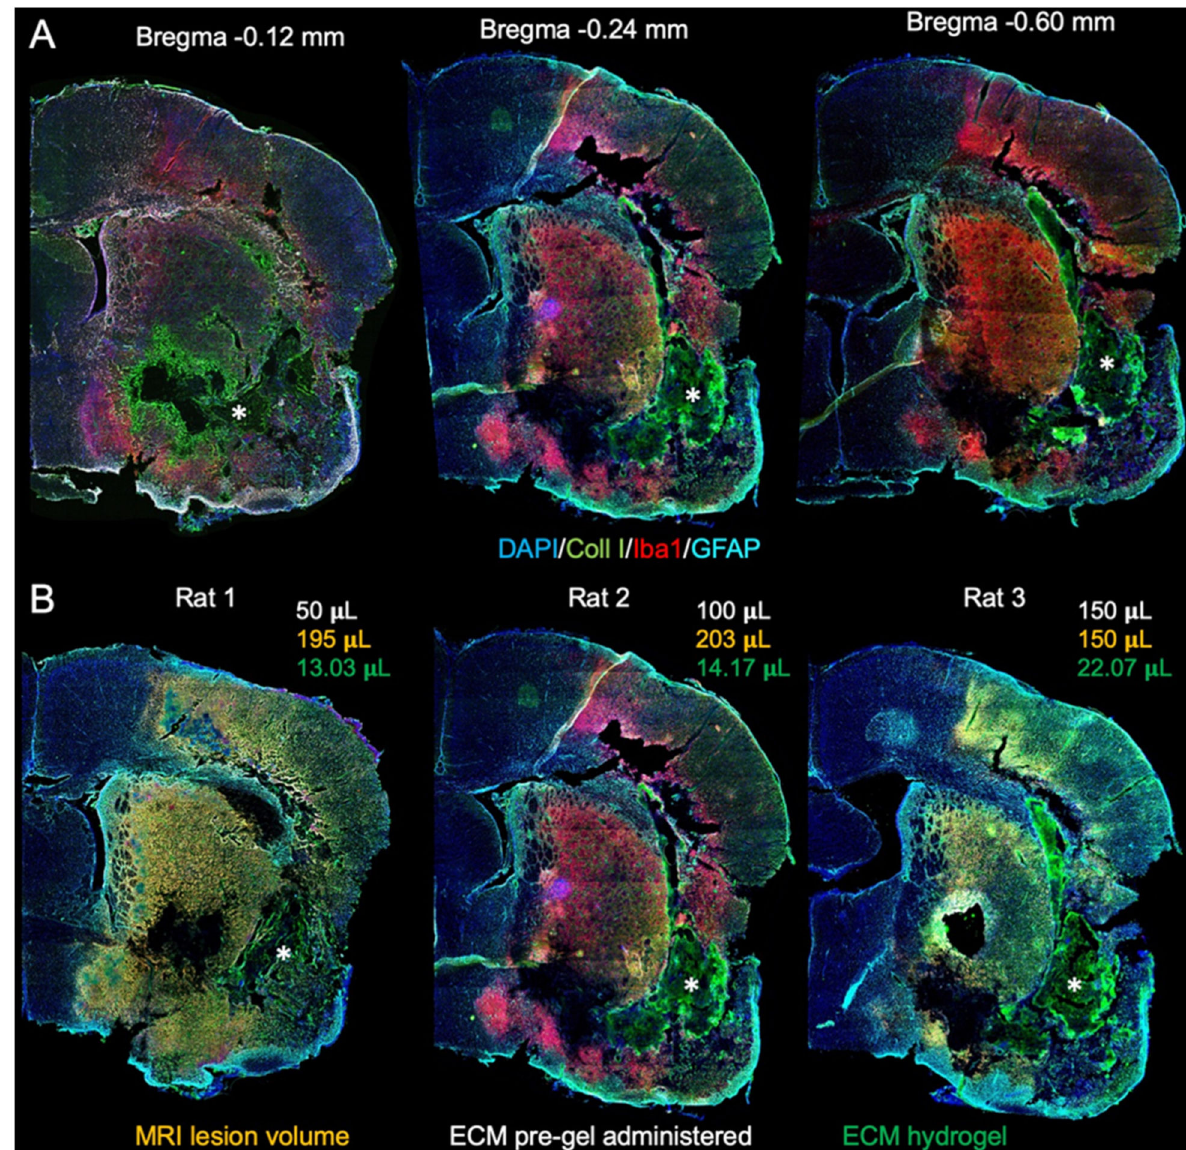
Figure 1. 7-days post-stroke implantation of ECM hydrogel. ( A ) Macroscopic whole brain slice images were acquired to examine the distribution of ECM hydrogel injected 7-days post-stroke. Collagen I staining visualized the ECM hydrogel (*) based on an intensity difference of collagen I content in the bioscaffold compared to the veterate brain. ( B ) There was a poor distribution of ECM hydrogel throughout the stroke-damage region, irrespective of the administered pre-gel volume. Only a small volume (13–22 µ L) of the administered ECM pre-gel was retained within these brains, akin to what is expected after intra-parenchymal